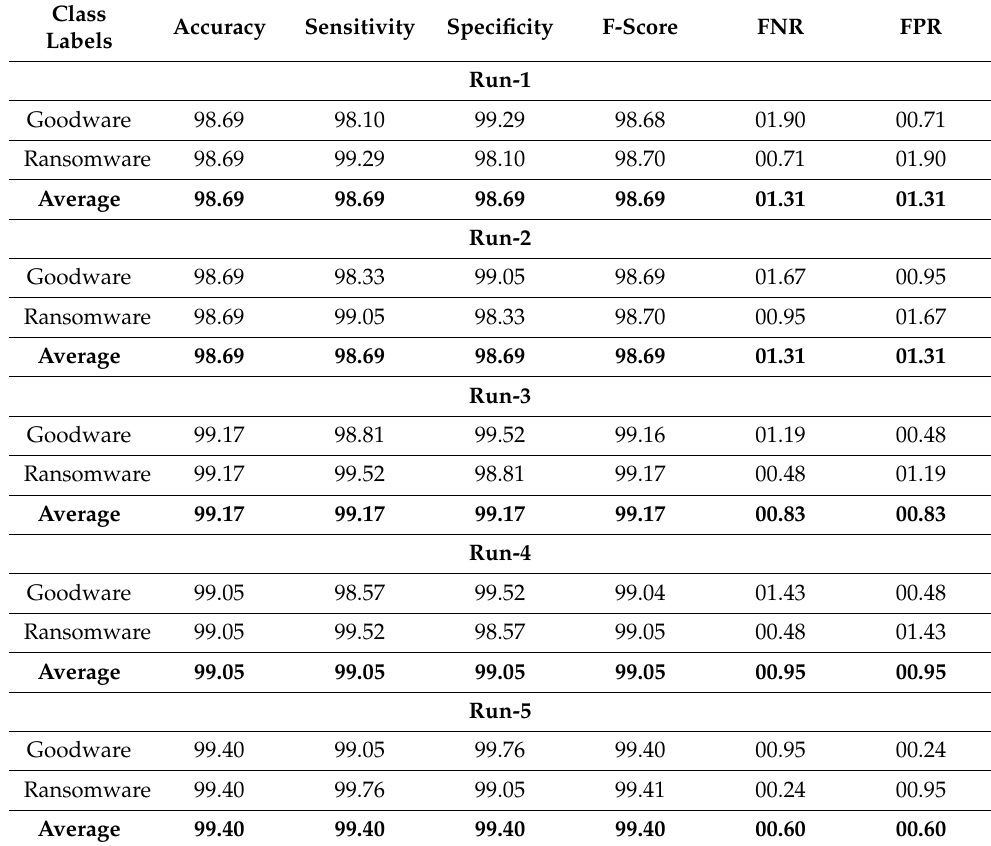
Table 2. Result analysis of DWOML-RWD technique with distinct measures and